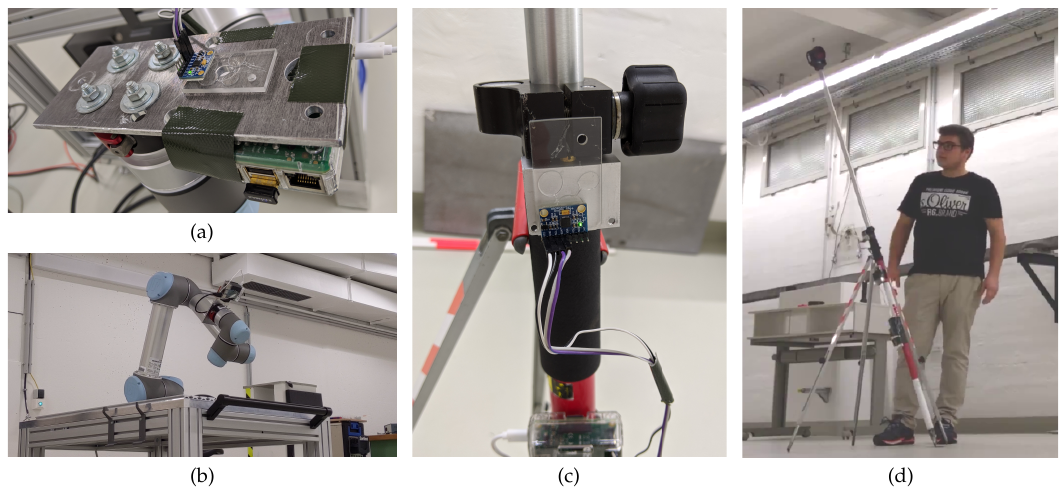
Figure 8. ( a ) the IMU MPU6050 mounted on the robots end-effector. ( b ) the robot UR5 performing the calibration routine. ( c ) the IMU mounted at the prism pole. ( d ) One of the authors performing the mounting estimation.